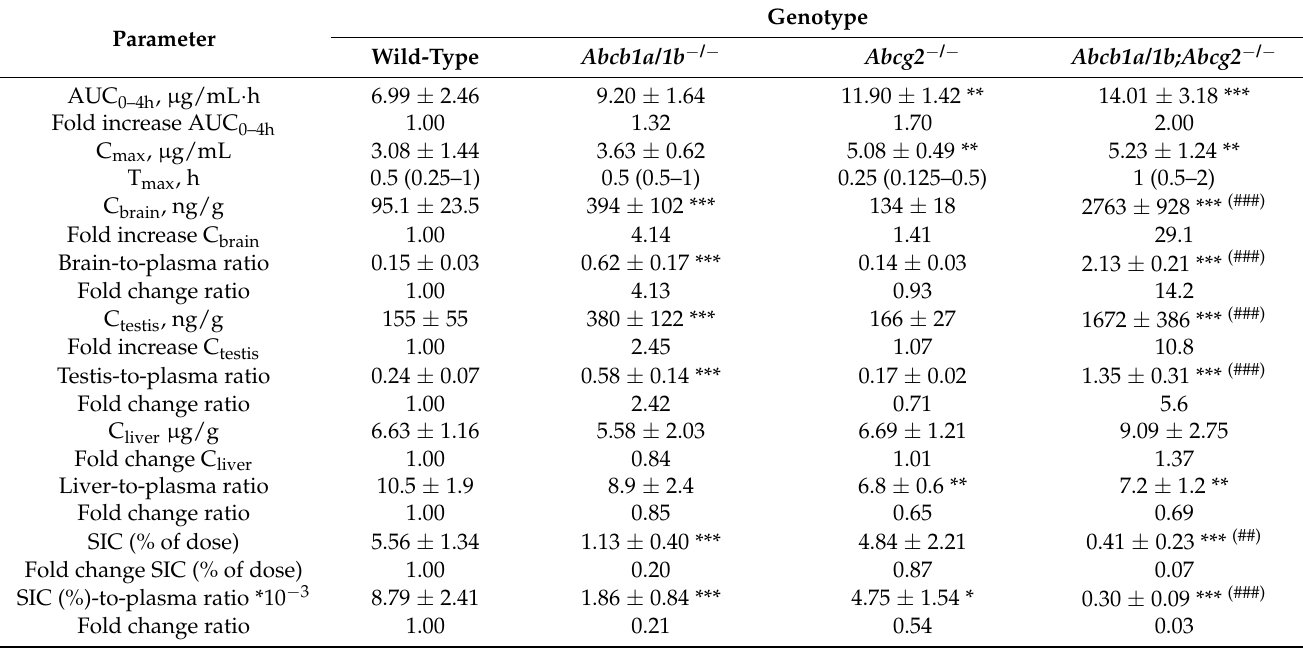
Table 1. Plasma, brain, liver, testis and small intestine pharmacokinetic parameters of repotrectinib 4 h after oral administra- tion of 10 mg/kg repotrectinib to male wild-type, Abcb1a/1b − / − , Abcg2 − / − , and Abcb1a/1b;Abcg2 − / − mice. Parameter